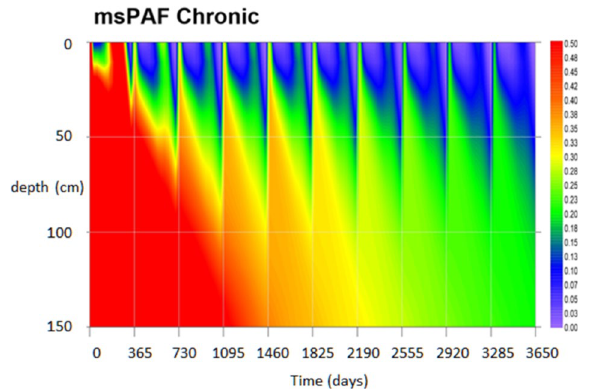
Fig. 6 Chronic ms-PAF (as fraction) in the soil pore water during a period of 3650 days (10 year cycles). Time (in days) on the x-axis, the soil depth (in cm) on the y-axis